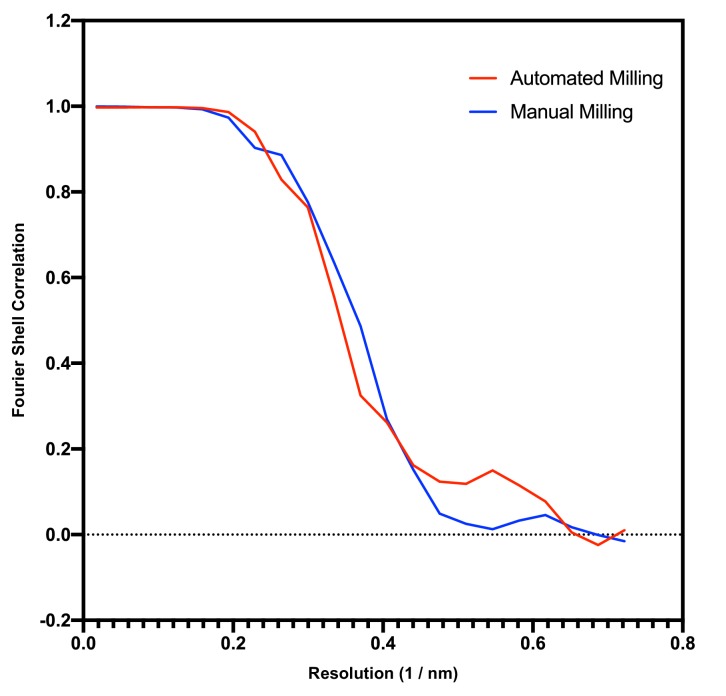
Comparison of data quality between manual and automated milling.Shown is a Fourier Shell Correlation (FSC) curve (red) for the septal junction subtomogram average shown in Figure 3F (resulting from automated milling). The second curve (blue) results from a dataset published previously (Weiss et al., 2019) (resulting from manual milling) and was calculated with the same number of randomly selected subvolumes after fivefold symmetrization (n = 1715). Both approaches result in a comparable resolution estimate.Figure 3—figure supplement 1—source data 1.Source data for Figure 3—figure supplement 1.